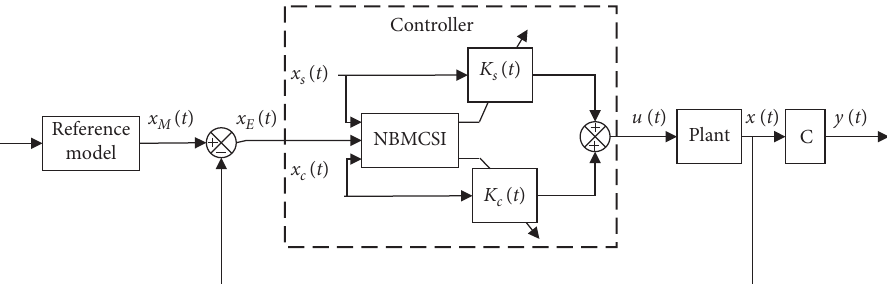
Figure 17: Er-MCSI controller [52].